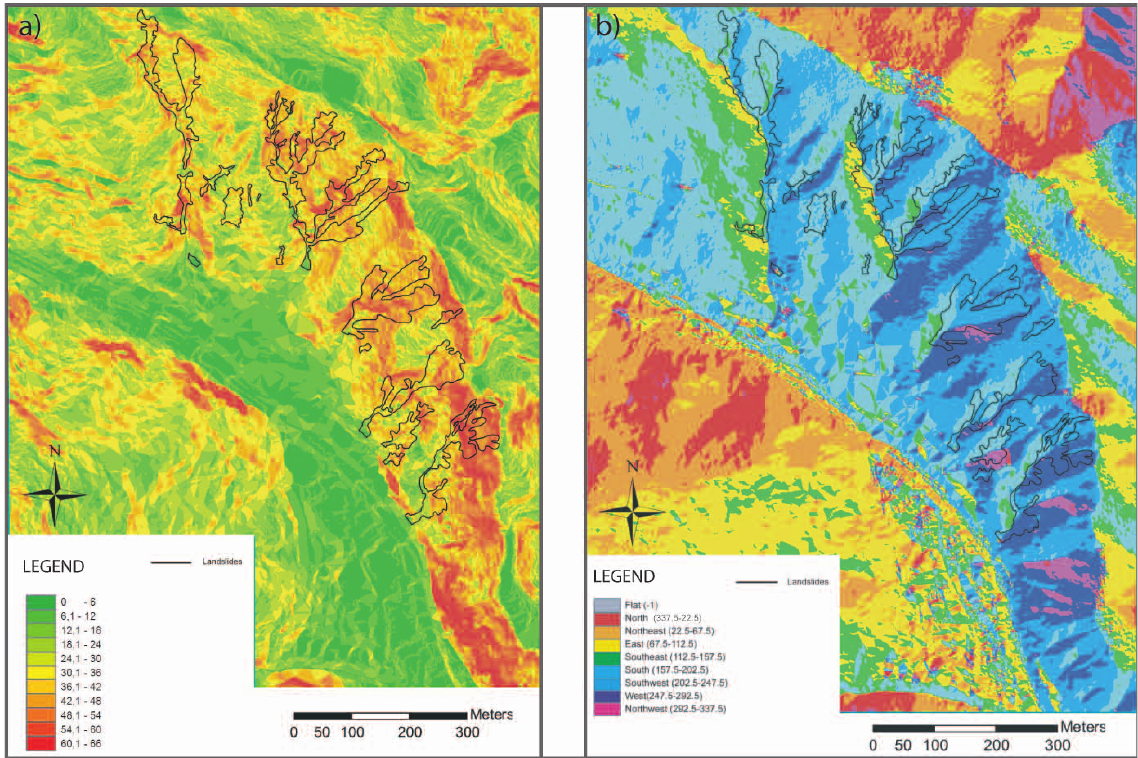
Fig. 7. (a) Localisation of detachment zones on the slope map, calculated from the pre-event DEM. Landslides affecting the area were identified through post-event orthorectified aerial images. (b) Map of October 2009 disruptions displayed onto the aspect map, with resolution of 1m, elaborated from LIDAR data.